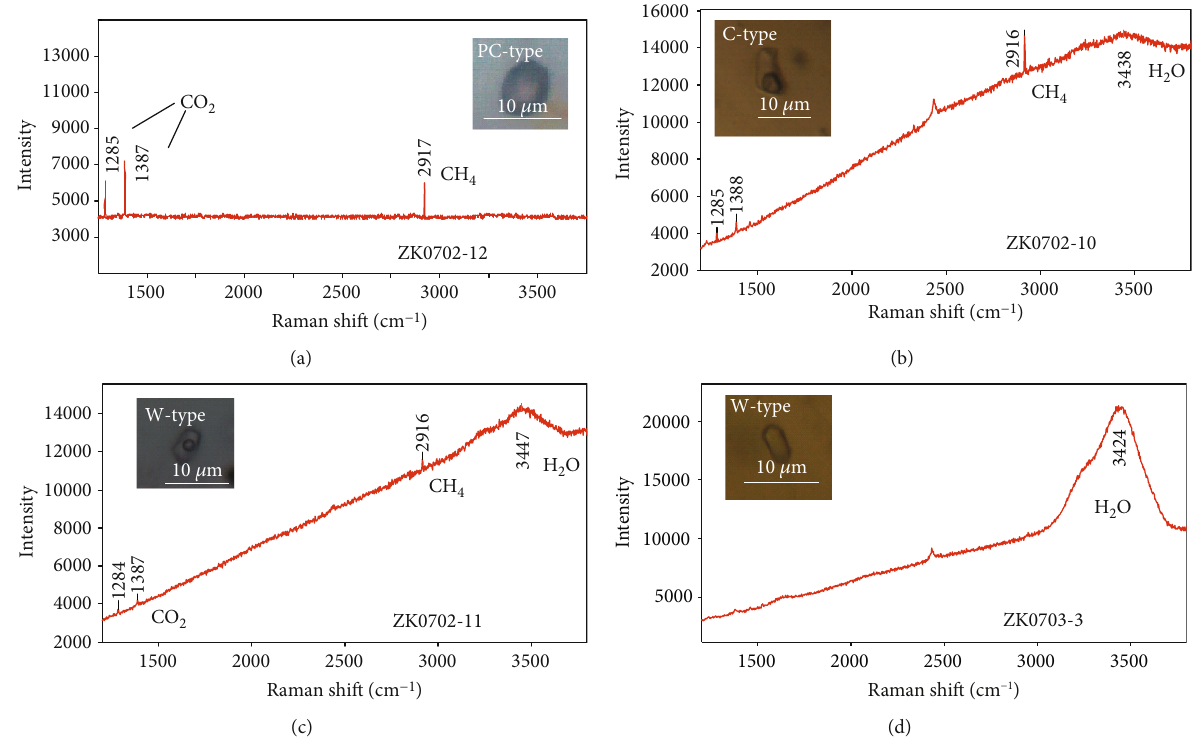
Figure 7: Microstructures and laser Raman spectra for fl uid inclusions in Yuka gold deposit. Table 2: The δ D , δ 18 O , and δ 18 O ( ‰ ) of the Yuka gold deposit. V − SMOW V − SMOW H2O